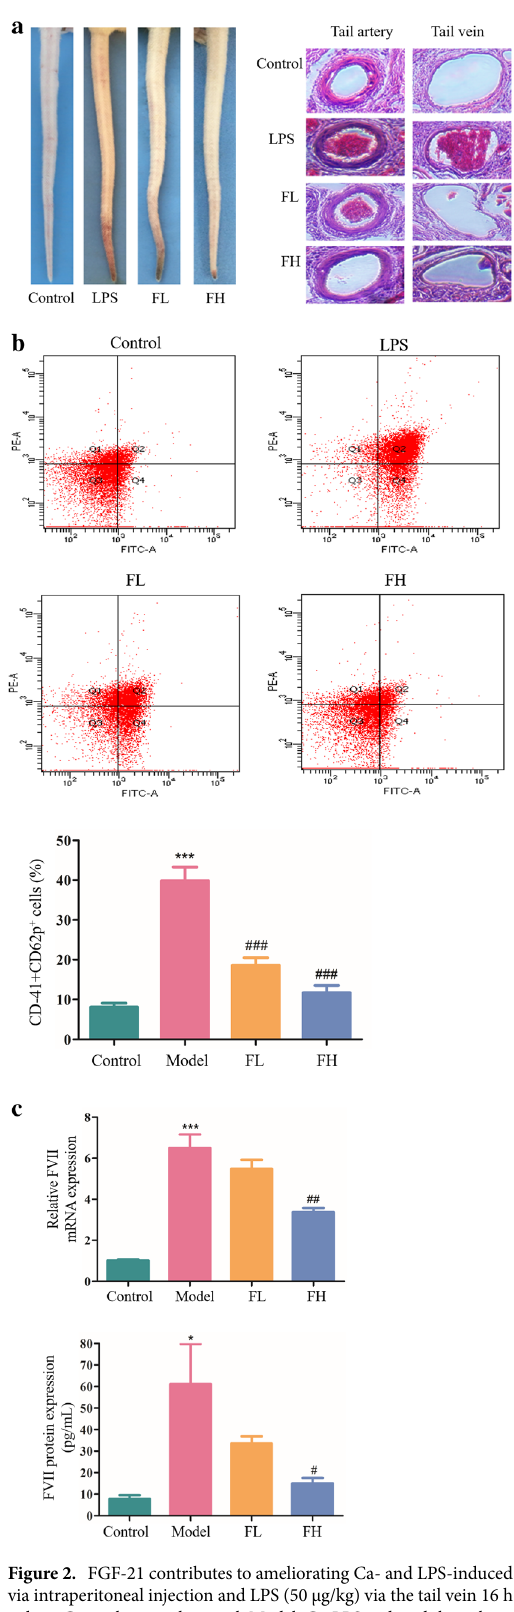
Figure 2. FGF-21 contributes to ameliorating Ca- and LPS-induced tail thrombosis in mice. Mice were administered Ca (3 mg/kg) via intraperitoneal injection and LPS (50 µg/kg) via the tail vein 16 h later. Then, FGF-21 was administered to the mice once daily for 5 days. Control: normal control; Model: Ca-LPS-induced thrombosis mice; FL: thrombosis mice treated with low-dose FGF-21 (5 mg/kg); FH: thrombosis mice treated with high-dose FGF-21 (10 mg/kg); FVII: factor VII; FVIIa: activity of FVII. ( a ) Representative image of tail and HE staining of tail artery and vein sections (×10) in mice. ( b ) CD 41+ and CD 62p+platelets from mice in each group. ( c ) Analysis of FVII expression in the liver by real-time PCR and in the serum by ELISA. For all the bar graphs, data are expressed as the mean±SD (n = 6). One-way ANOVA was used for multiple group comparisons, followed by Student’s two-tailed t test. * p < 0.05, ** p < 0.01, *** p < 0.001 compare with Control; ## P < 0.01, ### P < 0.001 compare with